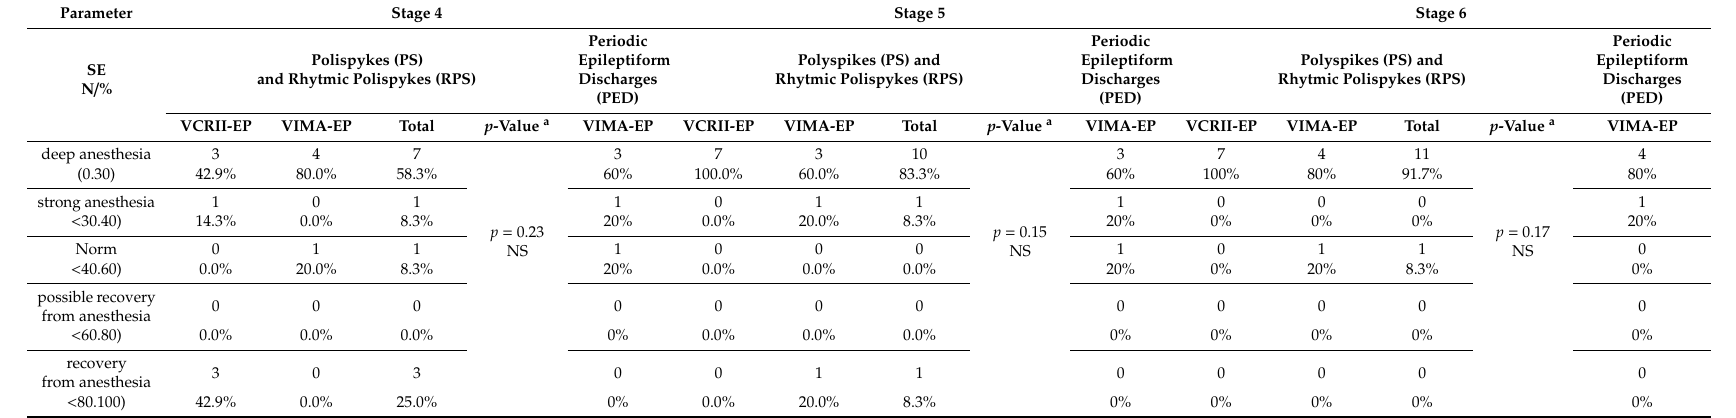
Results presented as numbers (percentages) for discrete variables. a the Fisher’s Exact